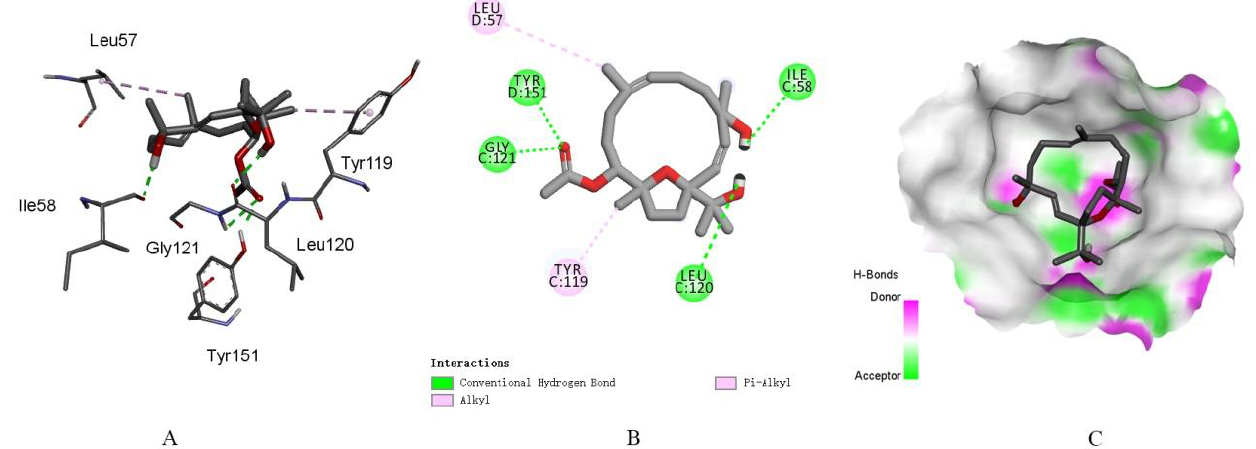
Figure 6. The binding modes of compound 1 at TNF- α crystal structure 2AZ5: ( A ) the clear com- bination of hydrogen bonds and other interactions within the target pocket; ( B ) two-dimensional ligand interaction diagrams of compound 1 at the crystal structure of the TNF- α protein domain; and ( C ) surfaces of 2AZ5 with the combined compound.